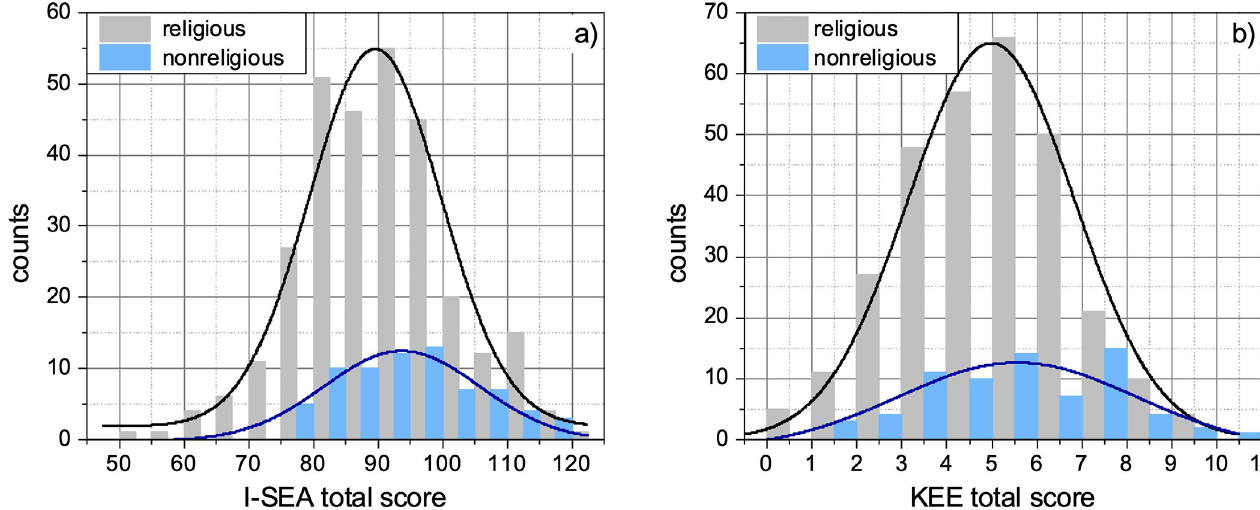
Fig 2. Histograms of the total score obtained in the two questionnaires, (a) I-SEA and (b) KEE, after categorizing the total population of students into religious (N = 299) and nonreligious (N = 71). The solid lines correspond to the fit of the distribution to a Gaussian function (see text for details).